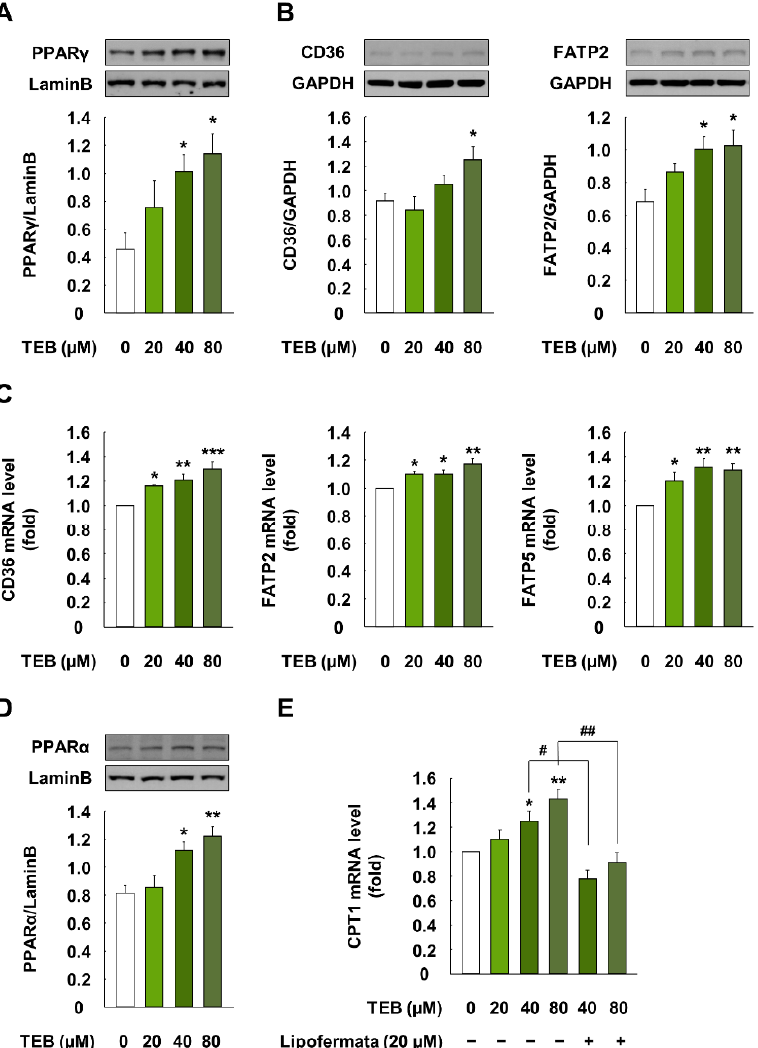
Figure 3. Expression of lipid uptake and lipid oxidation-associated molecules in HepG2 cells when treated with TEB. ( A ) Protein level of nuclear PPAR γ (1:3,000 dilution) in HepG2 cells; ( B ) protein and ( C ) mRNA levels of CD36 (1:3,000 dilution), FATP2 (1:3,000 dilution), and FATP5 (1:3,000 dilution) in cells; ( D ) protein levels of PPAR α (1:1000 dilution) in the nucleus and ( E ) mRNA level of CPT1 in cells. Cells were exposed to 20, 40, and 80 µM TEB for 1 or 12 h ( n = 3 wells/group). Lipofermata (20 µM) was added to the cells 1 h before the TEB treatment. Lamin B and GAPDH were used as housekeeping protein and gene, respectively. The data are represented as mean ± SEM. * ( p < 0.05), ** ( p < 0.01), and *** ( p < 0.001) show a significant difference, compared to the control (DMSO). # ( p < 0.05) and ## ( p < 0.01) show a significant difference, compared to the TEB-treated cells.